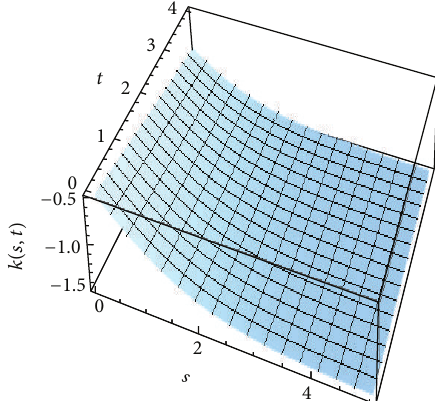
Figure 8: The curvature of the family of curves 𝐶 𝑡 for 𝑠 ∈ [0, 5] , = 1 , 𝑐 = 0 , and 𝑐 = 0 . 𝑡 ∈ [0, 6.3] , 𝑐 1 2 3